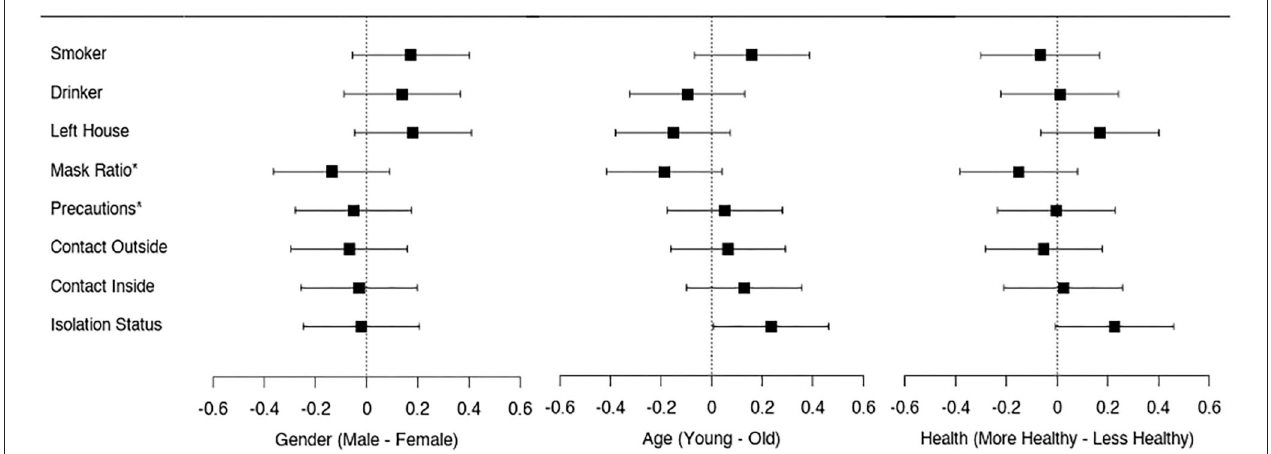
FIGURE 2 | Forest plot for the standardized (z-scored) mean differences with 95% confidence interval across the self-reported risky behaviors in study 2 (UK representative sample) by gender, age (classified as young and old by median age), and self-reported health (classified as more and less healthy by median self-reported health). A positive number indicates higher real-world risk taking by male participants compared to female participants, by younger compared to older participants, and by healthier compared to less healthy participants, respectively. *Mask Ratio and Precautions have been inverted by multiplying the corresponding group means by minus one so that a higher score indicates higher risk taking.